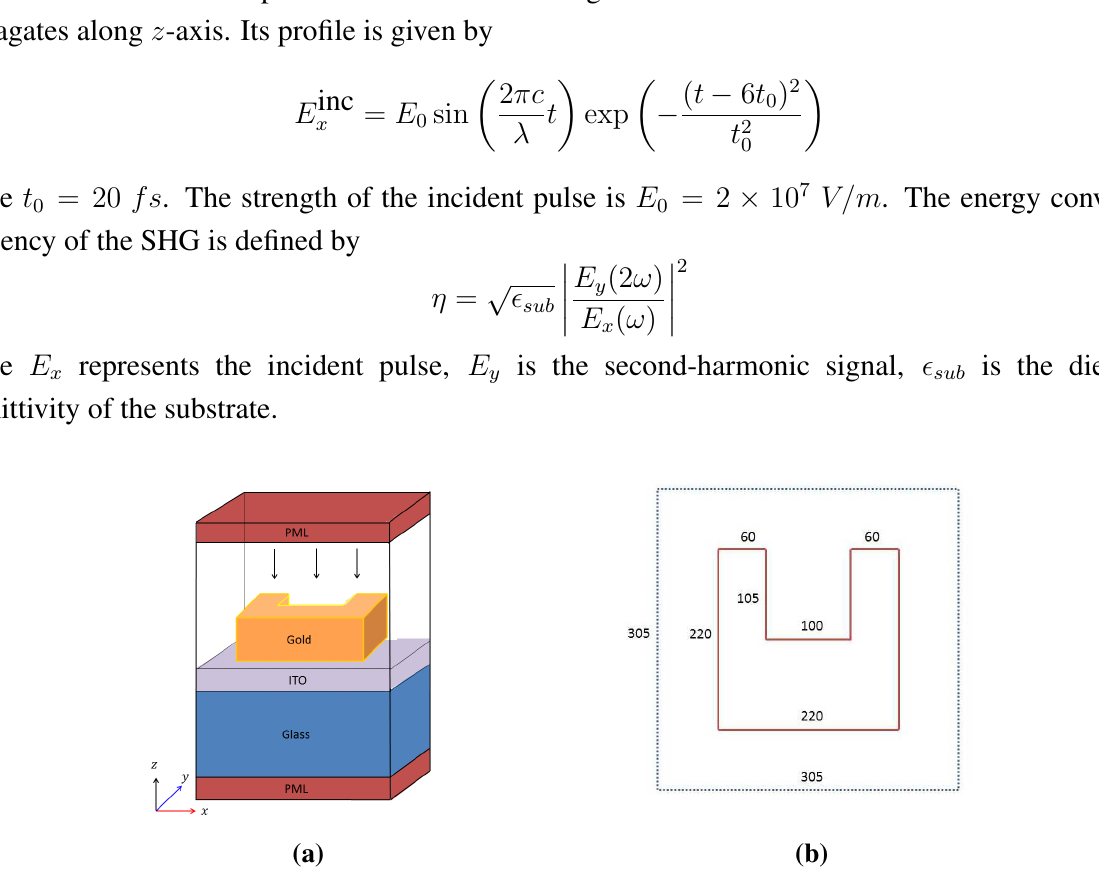
Figure 1b. ITO ( (cid:15) = 3 . 8 and 5 nm thick) and glass ( (cid:15) = 2 . 25 below ITO to the bottom) substrates are placed beneath the particle. The rest of the computational domain is vacuum.